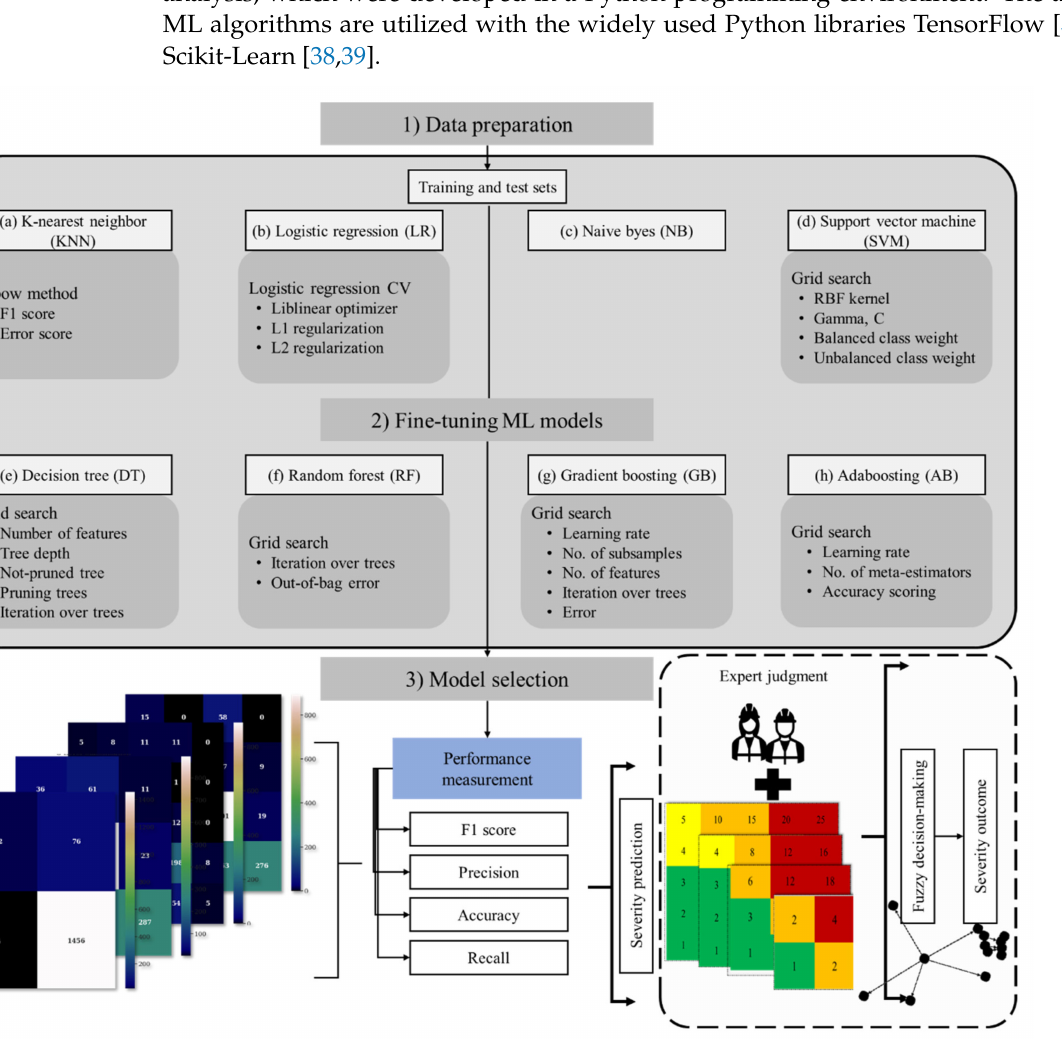
Figure 2. Outline of customized